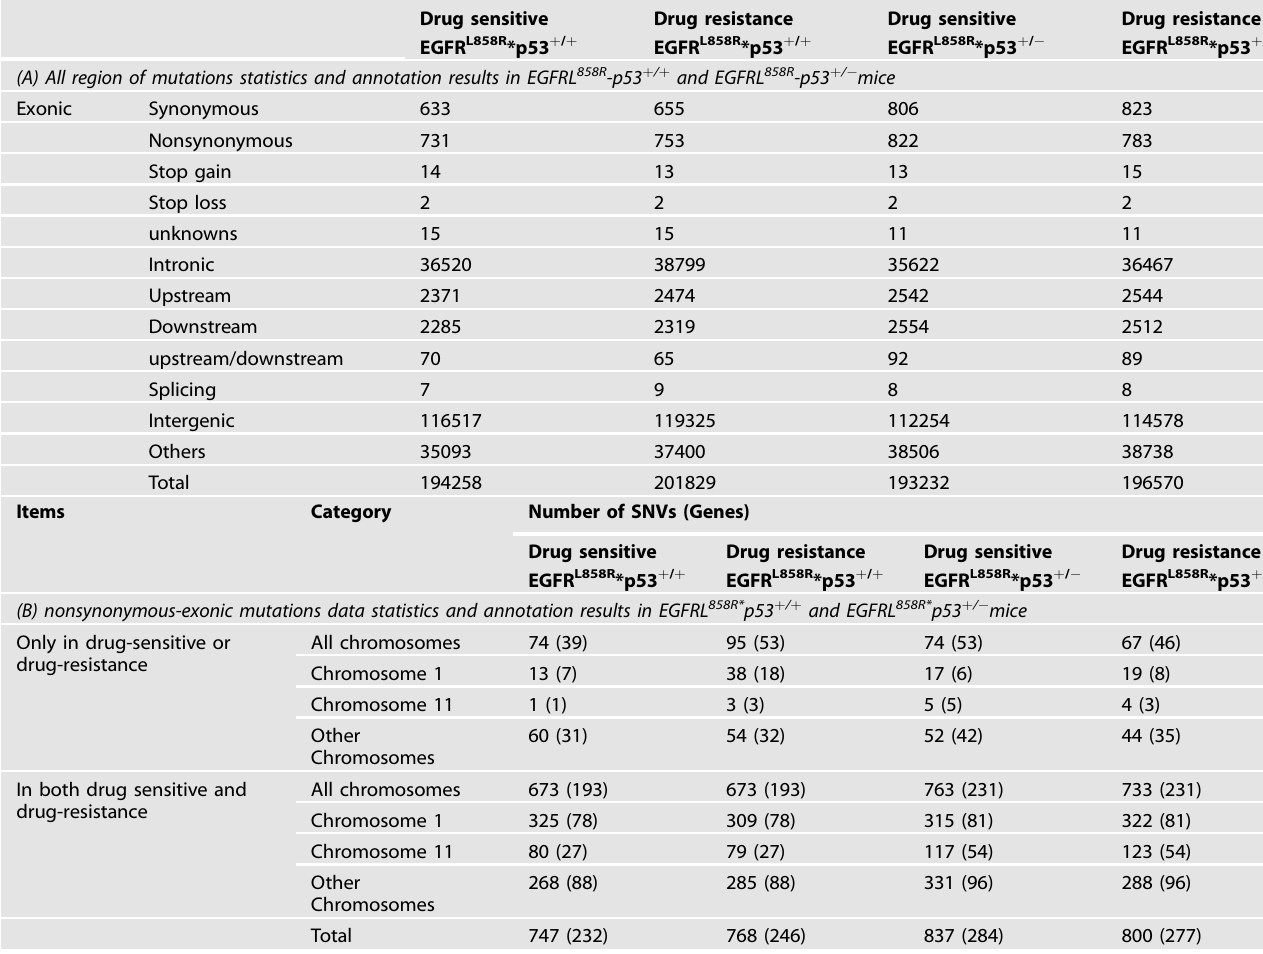
Table 1. The mutation statistics and annotation results for lung cancer formation, drug resistance and mice with Tp53 + / − -mediated drug resistance are listed here (A). The exonic nonsynonymous mutation statistics and annotation results for lung cancer formation, drug resistance and mice with Tp53 + / − - mediated drug resistance are listed here